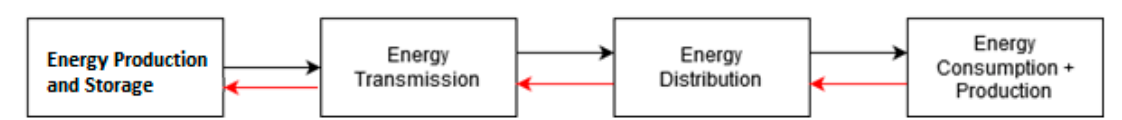
Figure 3. Schematic representation of future energy systems.